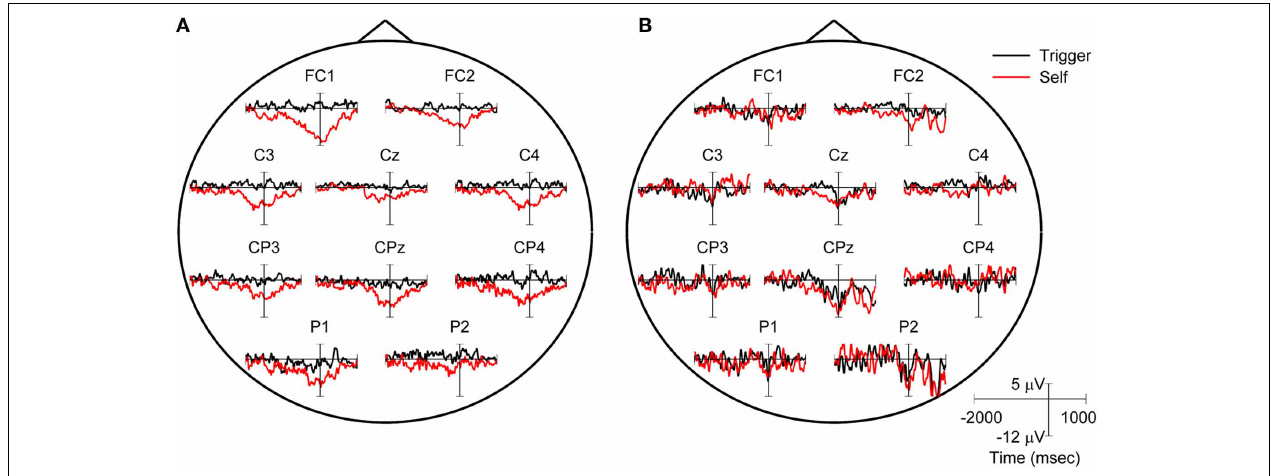
FIGURE 5 | Example of movement related potentials (MRPs) recorded in two different subjects. (A) MRP from S5 indicating a difference between triggered (black line) and self-initiated (red line) movements. (B) MRP from S9